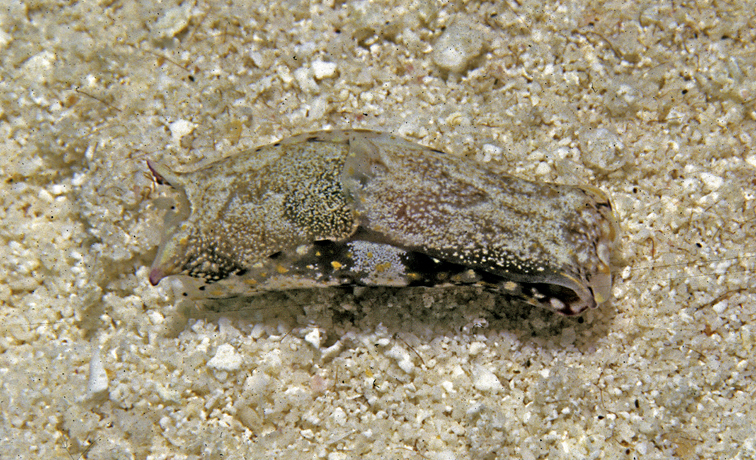
Philinopsis speciosa, 18 mm pres., Maldives, photo: RC Anderson.